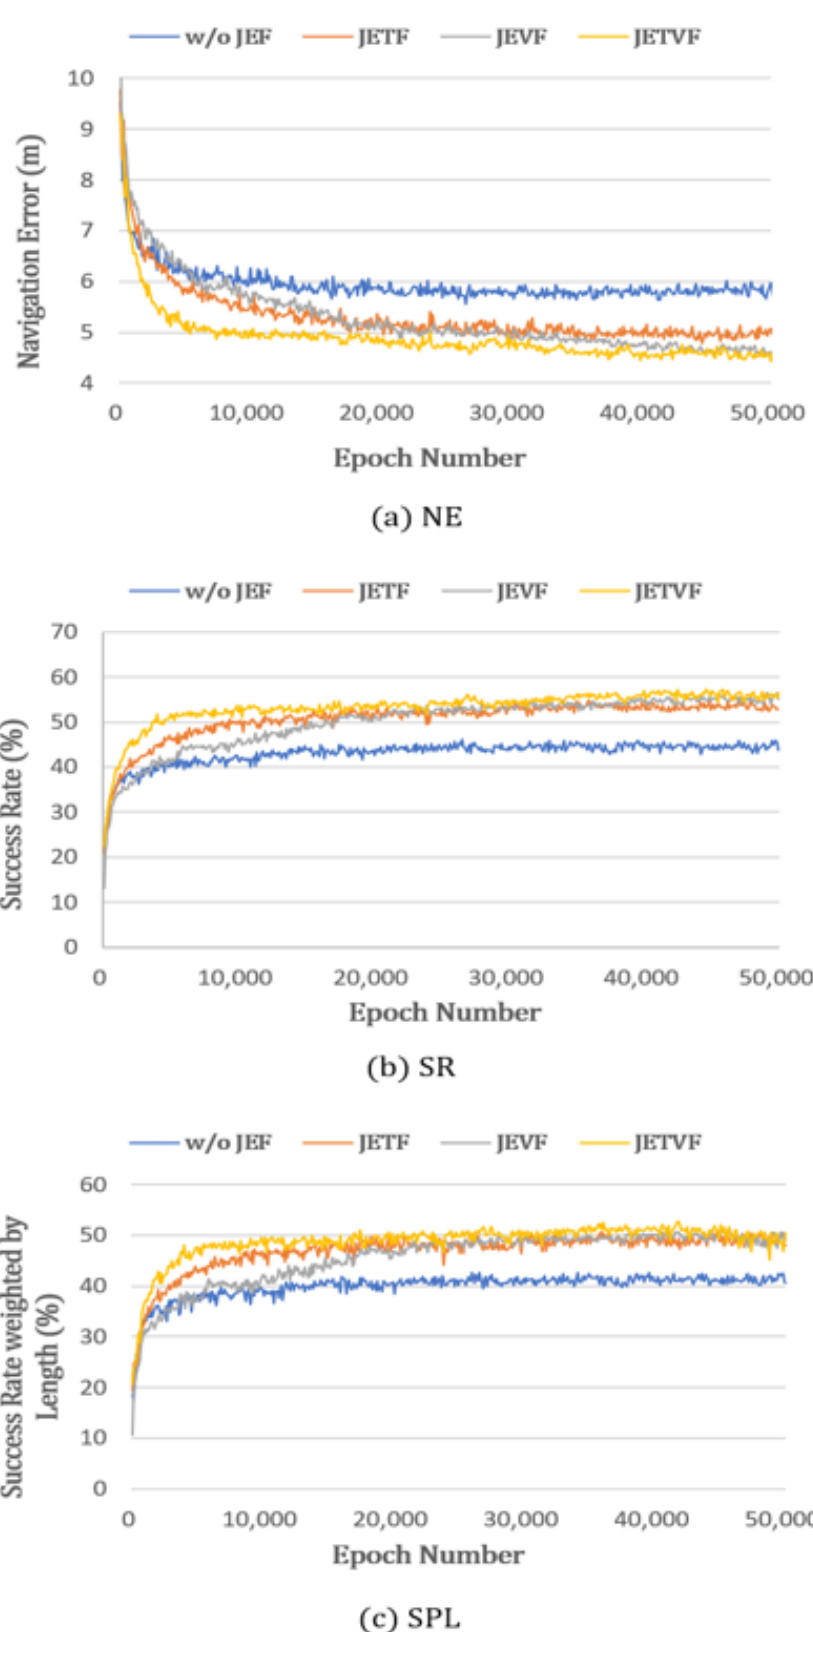
Figure 8. Comparison of performance using different embedding features: ( a ) navigation error (NE), ( b ) success rate (SR), and ( c ) success rate weighted by path lengths